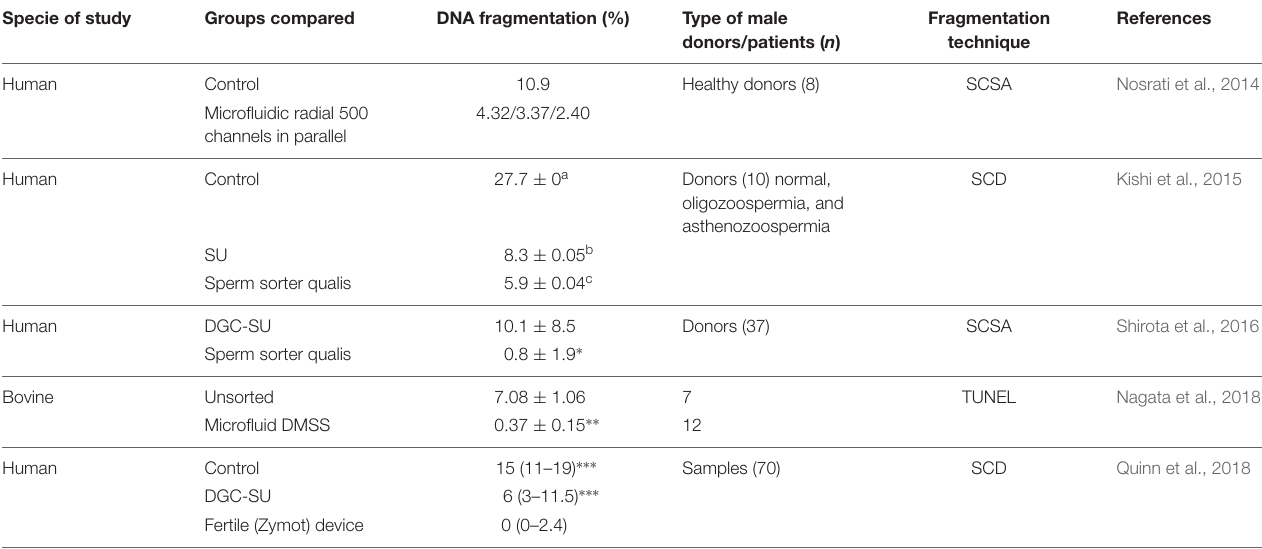
TABLE 8 | DNA fragmentation of spermatozoa selected by microfluidic